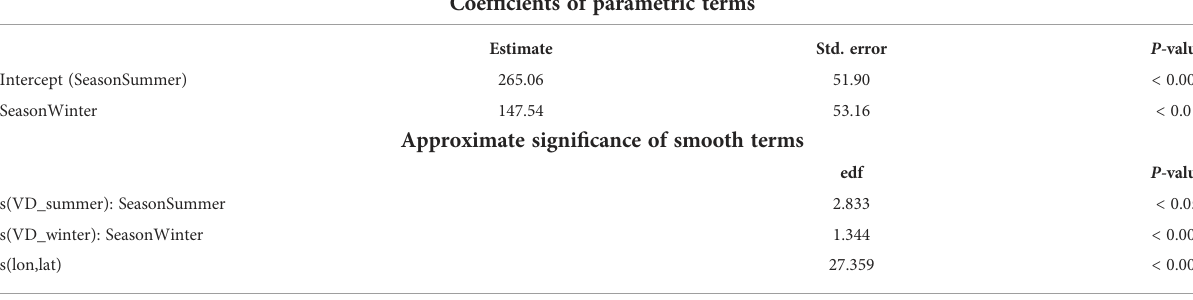
TABLE 2 Summary of the selected GAM model; edf=estimated degrees of freedom. Results -> log scale.